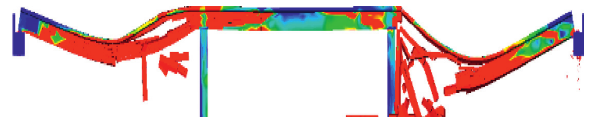
Figure 24: Principal normal strain at the end of the analysis, “model